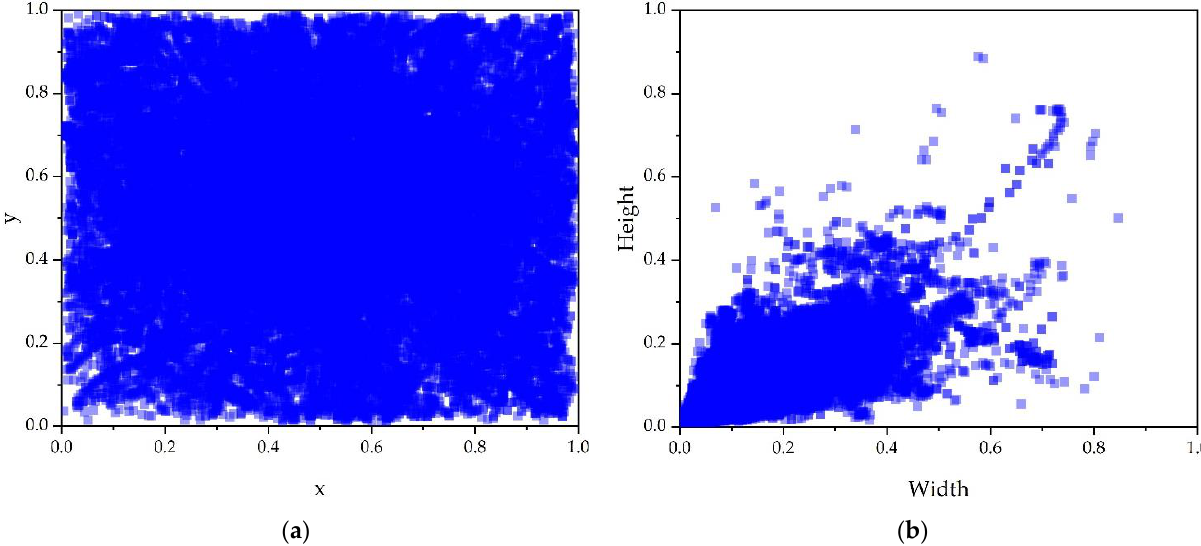
Figure 1. SWFD dataset visualization. ( a ) Position distribution of object center points, ( b ) object size distribution.